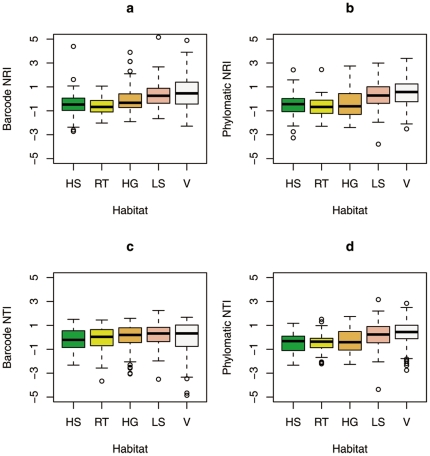
The total distributions of NRI or NTI values in different habitats generated from the molecular and Phylomatic phylogenies.The solid black line across the color box represents the median value. A hollow circle indicates an outlier value of NRI or NTI. HS, High-slope; RT, Ridge-top; HG, High-gully; LS, Low-slope; V, Valley.